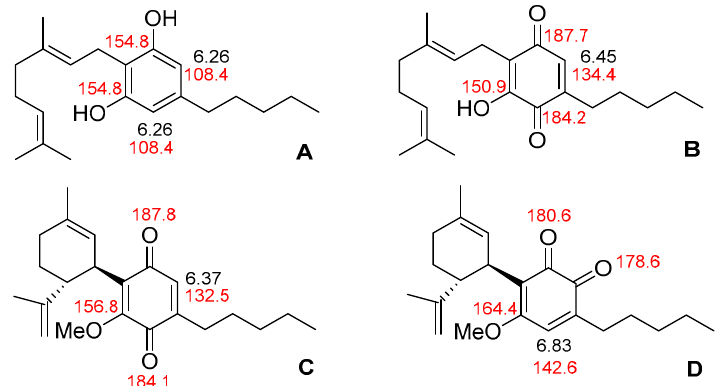
Figure 7. Top: Comparison of selected 1 H (black) and 13 C (red) NMR resonances of a phytocanna- binoid (CBG, A ) with those of the corresponding quinone ( B ). Bottom: Comparison of selected 1 H (black) and 13 C (red) NMR resonances of O -methyl- p -CBDQ ( C ) and O -methyl- o -CBDQ ( D ).